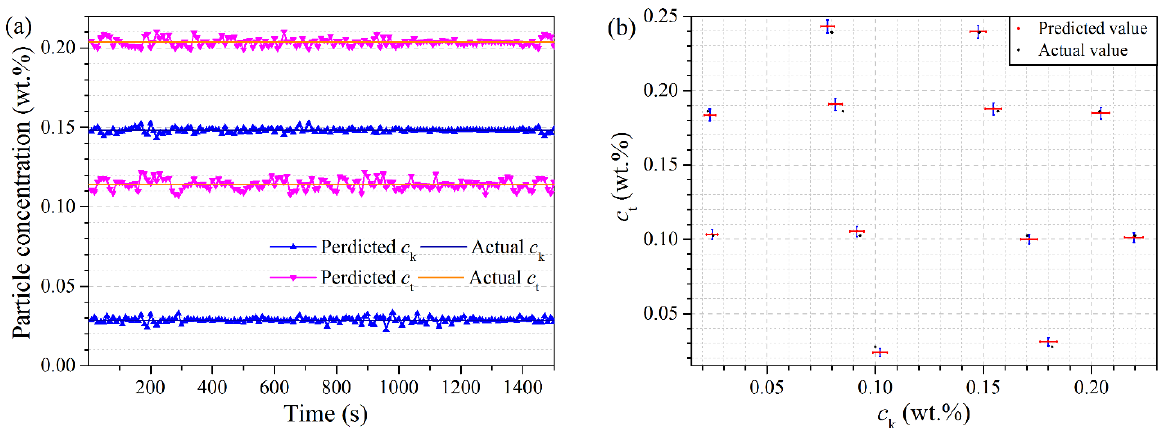
Figure 9. The result of inline measurement: ( a ) The real-time measurement concentration; ( b ) The XY error bar graph of the averaged c k and c t in 5